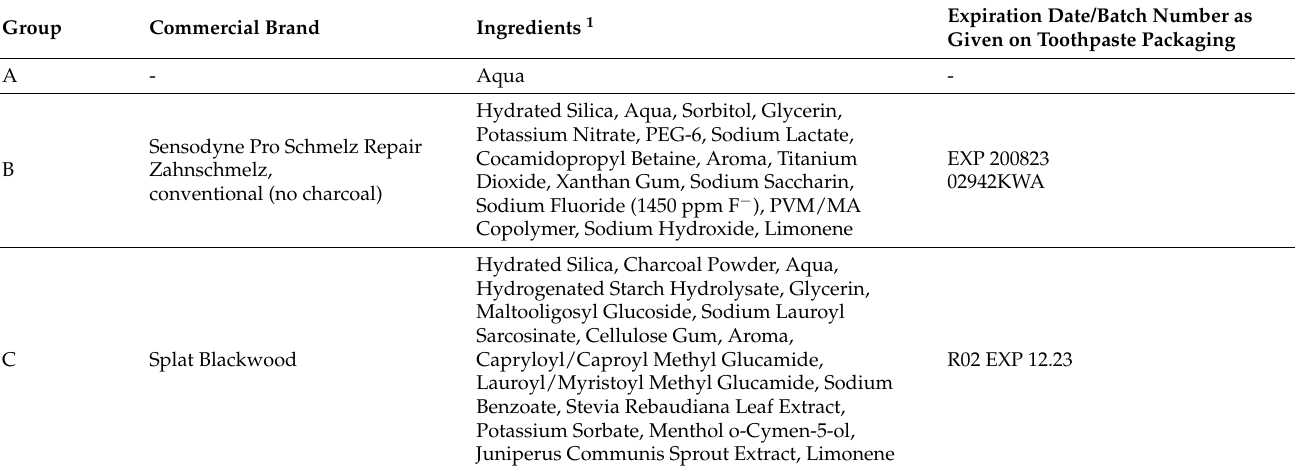
Table 1. Information about the ingredients of the toothpastes used. The ingredients are the same as in our previous work